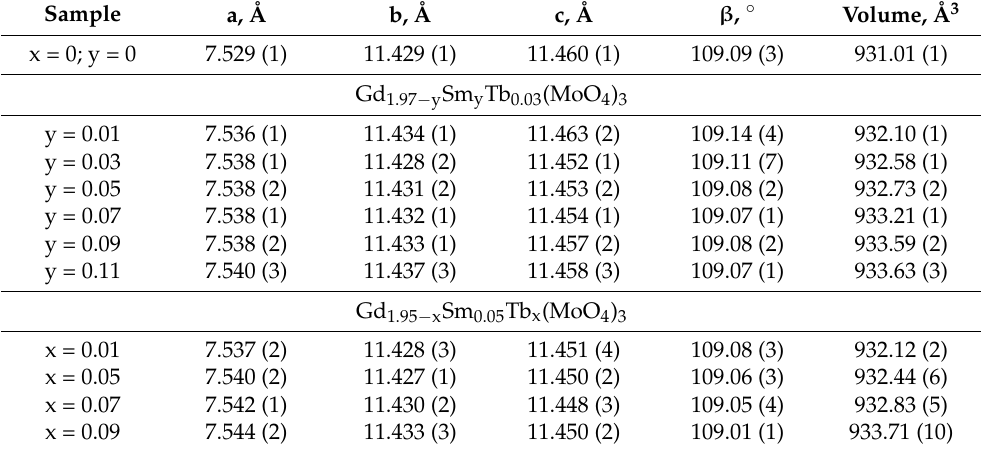
Table 1. Unit cell parameters of the samples of Gd 2 − x − y Sm y Tb x (MoO 4 ) 3